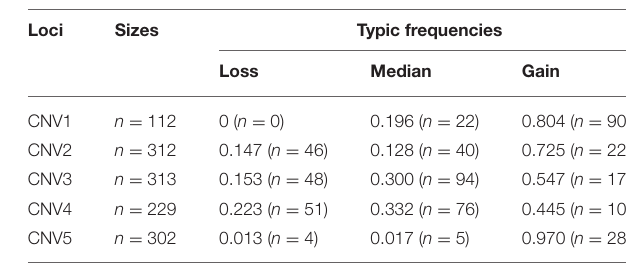
TABLE 3 | Typical frequencies of copy number variations within Fec B gene in Shaanbei white cashmere